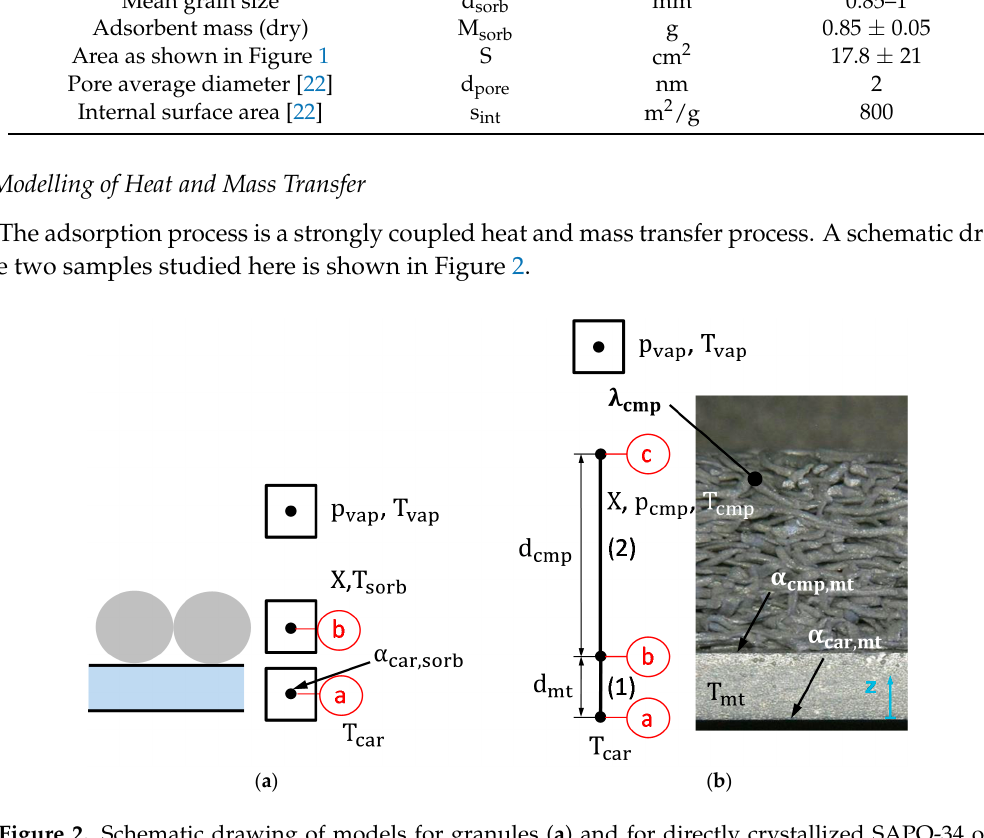
Table 2. Data of the loose grains configuration of Siogel (3_Sio).